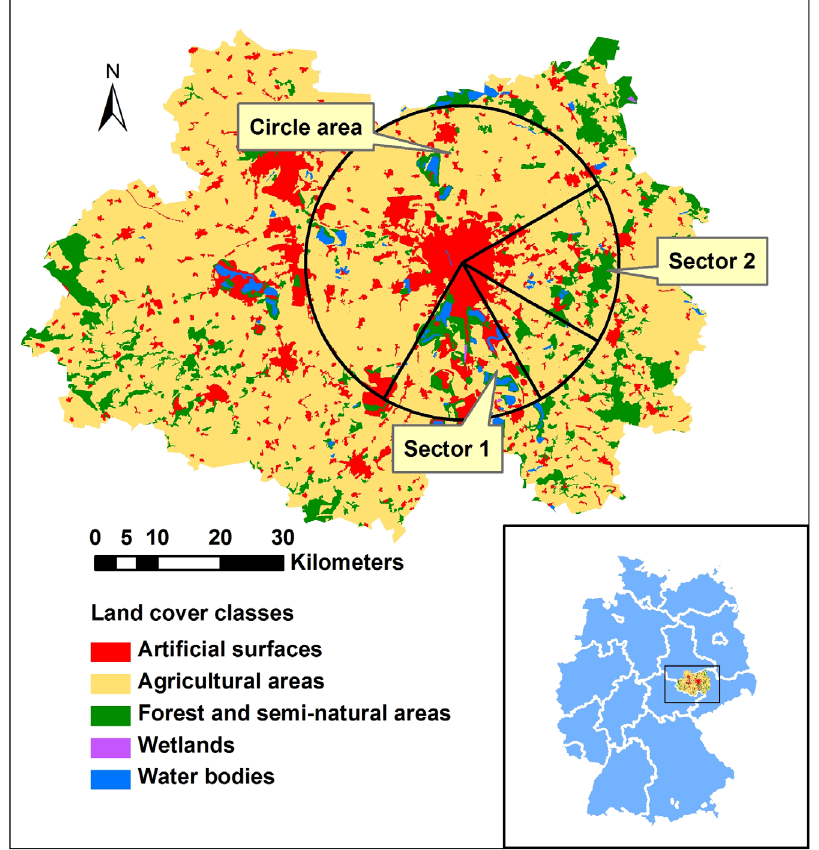
Figure 1: Land cover map of the Leipzig urban-rural area for 2006. The five primary classes are aggregated from Corine land cover classes (German Federal Environmental Agency, 2014). The circle area, sector 1 and sector 2 are the investigation areas with the city center of Leipzig in the centers and radiuses of 25 kilometers for gradient